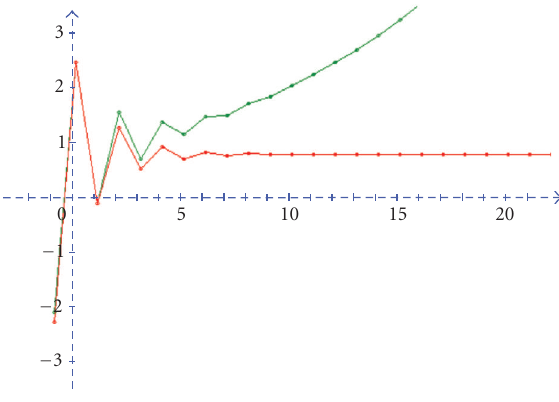
Figure 3.3. Behavior of x n and y n in the point E